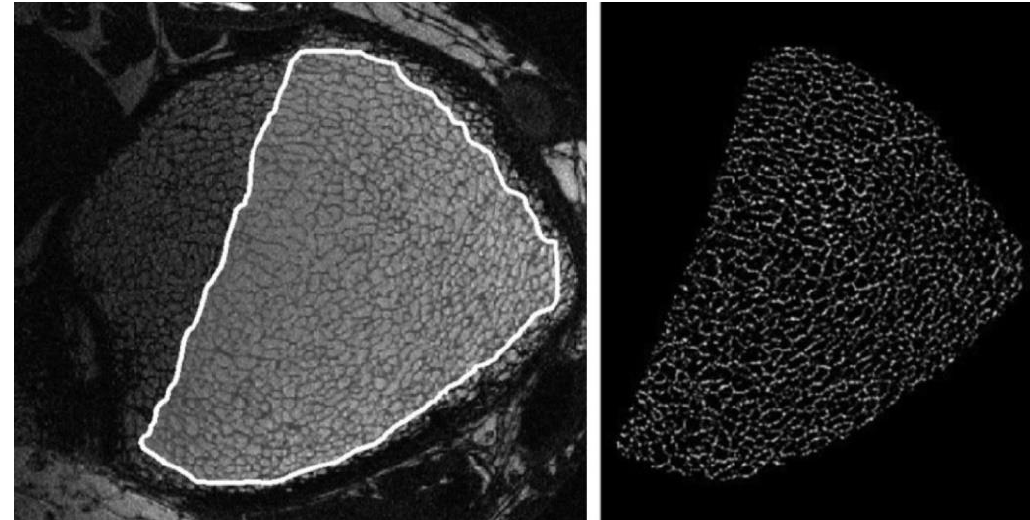
Figure 9. Processing phases of a magnetic resonance (MR) image of a human distal tibia: selection of the trabecular bone region ( left ) and its segmentation ( right ) (reproduced with permission from [54], John Wiley and Sons, 2007).